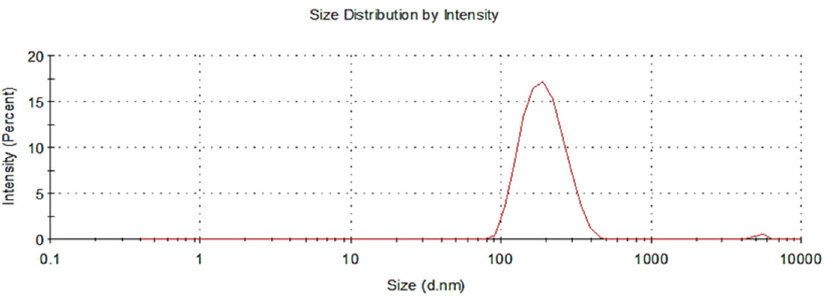
Figure 2. Particle size distribution profile of methotrexate-loaded polymeric TPGS-PLGA nanoparticles (nanoparticle formulation).